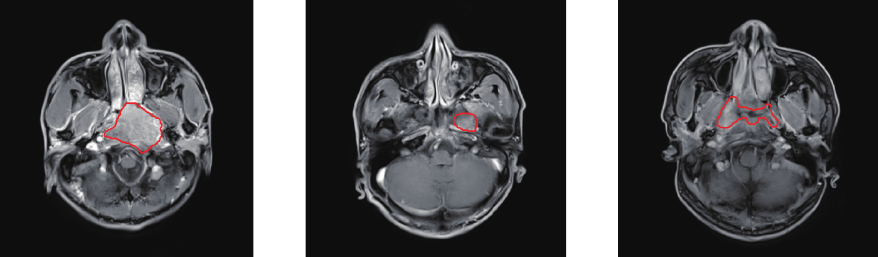
Figure 1. MRI slices of head and neck and tumour location of nasopharyngeal carcinoma. The area delineated by the red line is the result of the doctor’s manual